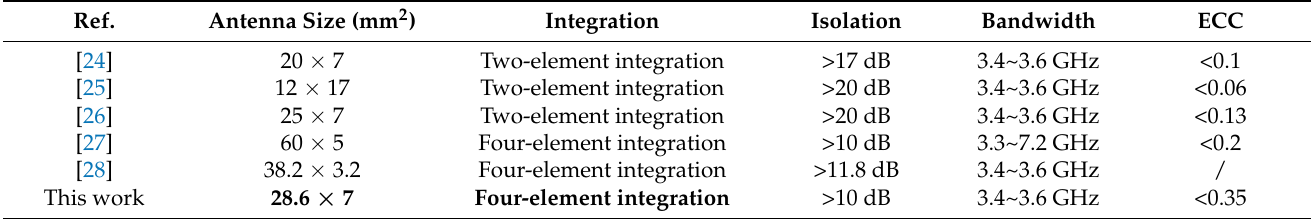
Table 1. Comparison of the proposed antenna pair with previous works.